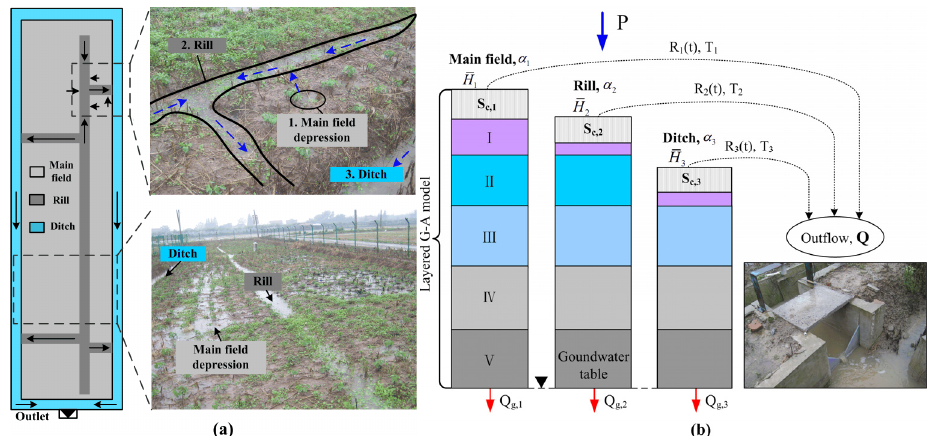
Figure 4. Schematic of rainfall–runoff model considering effects of microtopography: ( a ) a rainfall–runoff event at the field; ( b ) model structure.